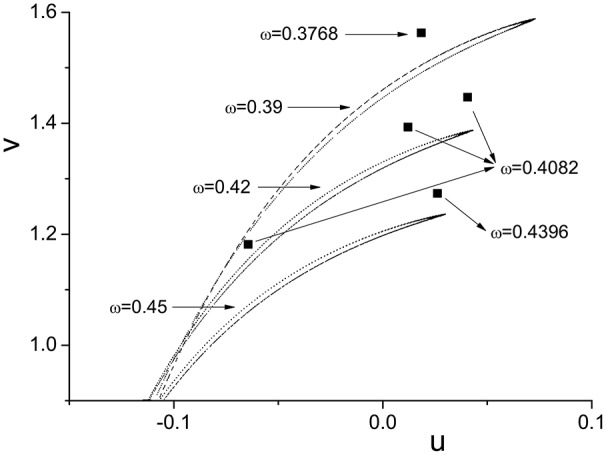
Poincáre sections at different ω. Transition of motion type when changing ω.